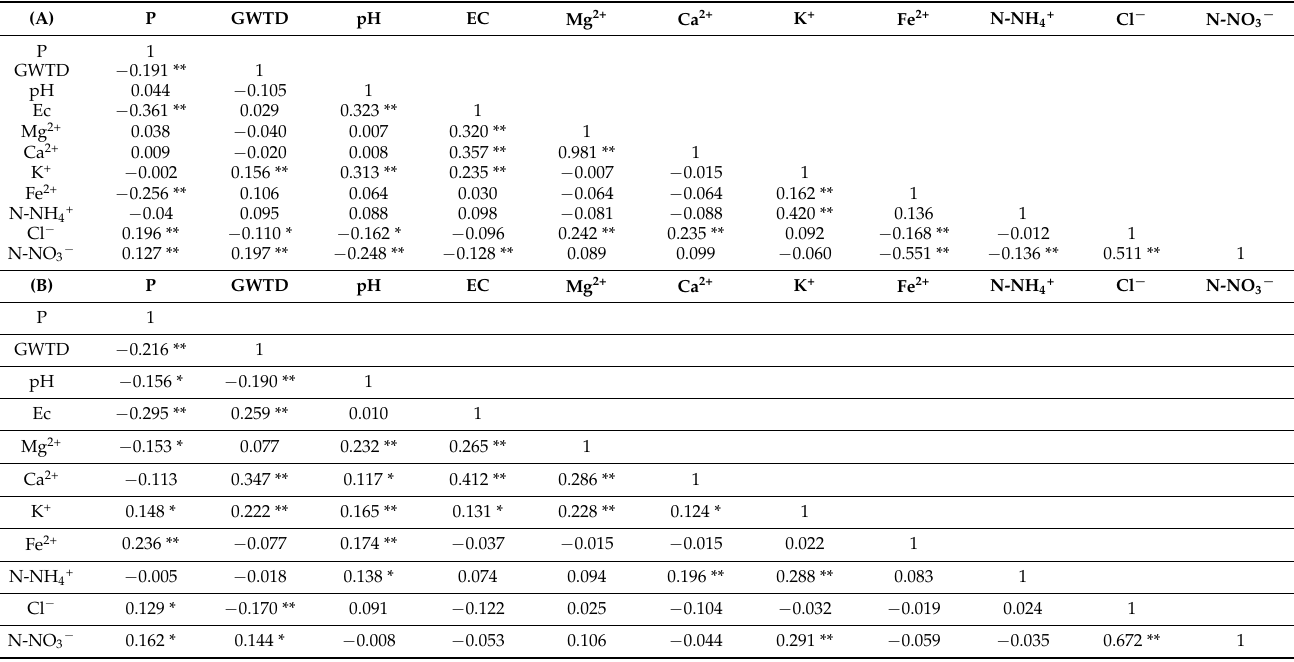
Table 3. ( A ) Pearson correlation coefficients between hydrological and chemical parameters for Dangishta; ( B ) Pearson correlation coefficients between hydrological and chemical parameters for Dangishta.